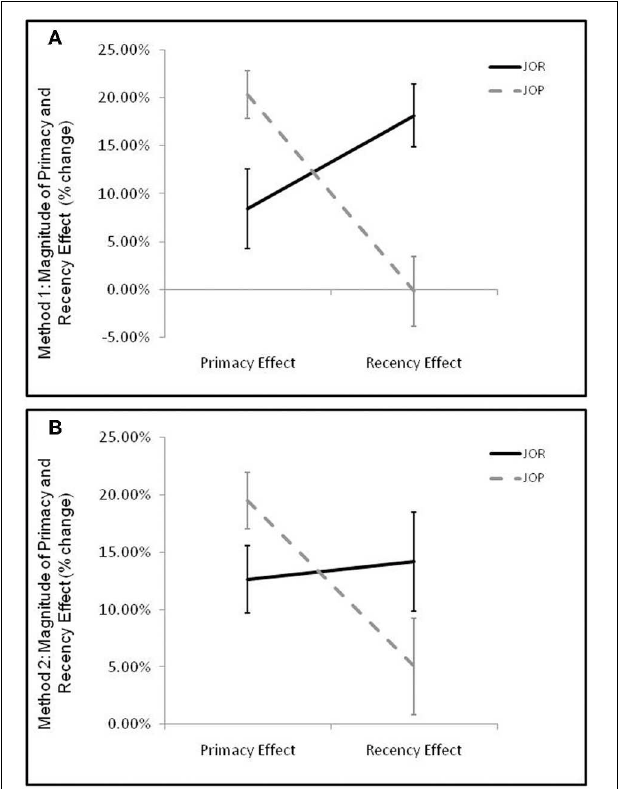
FIGURE 3 | Average magnitude of primacy and recency effects in JOR and JOP. Error bars represent the standard error of the mean. Calculation of primacy and recency effects produces an index of the percent reaction time advantage for retrieval of the primacy/recency item when compared to retrieval of middle items. (A) Primacy and recency effects in JOR and JOP calculated using method 1. Method 1 divides trials by the serial position of the correct probe item, and primacy and recency trials were defined by whether the earliest or latest possible correct response was the correct answer in the probe. (B) Primacy and recency effects in JOR and JOP calculated using method 2. Here, trials are divided by considering both items in the probe, and primacy and recency item trials are trials that include the earliest (primacy) or latest (recency)